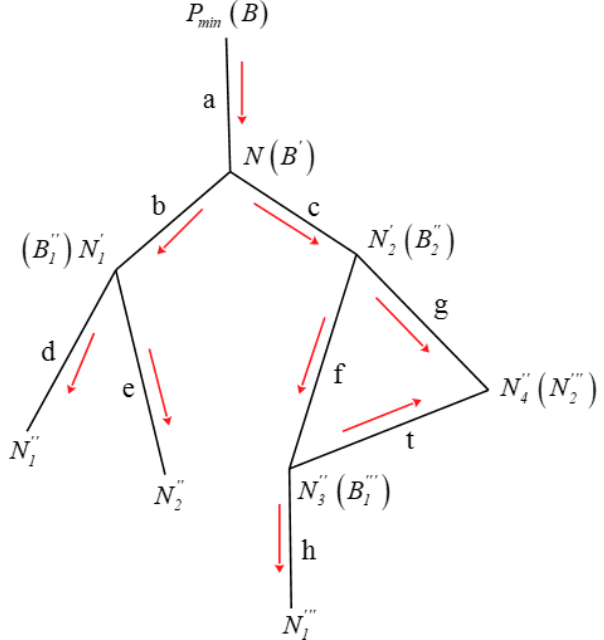
Figure 7. The schematic of calculating glacier length (the red ar- row represents the search direction of the branches of the glacier